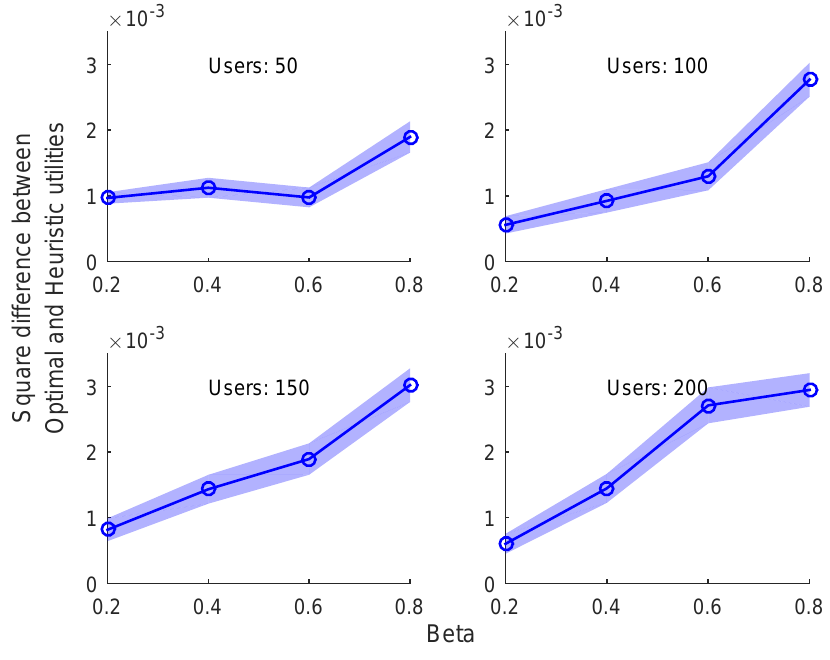
Figure 4. Confidence intervals for grid size = 3 ×